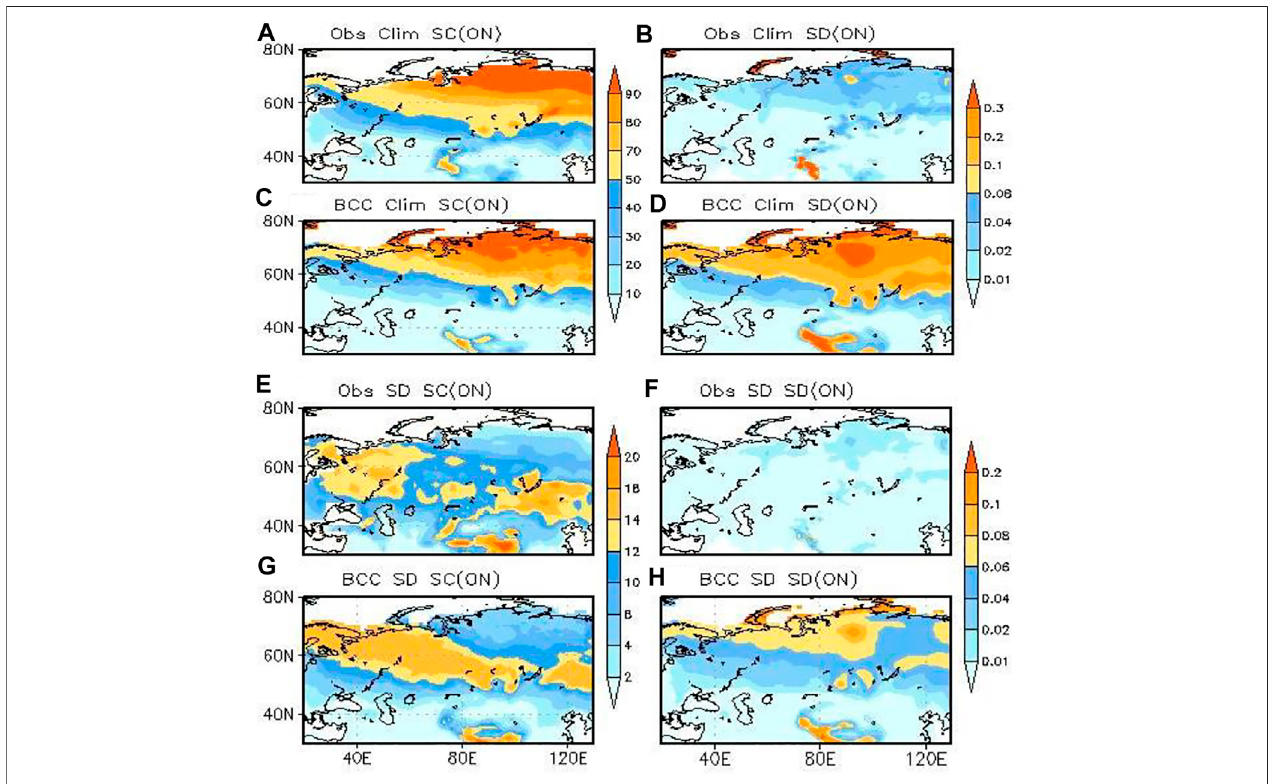
FIGURE 16 | The climatological ON mean (A) fractional snow cover (units: %), (B) snow depth (units: m) of observation, the simulated (C) fractional snow cover (units: %), and (D) snow depth (units: m) from BCC-CSM2-MR simulations. The standard deviation of ON mean (E) fractional snow cover (units: %), (F) snow depth (units: m) of observation, the simulated standard deviation of (G) fractional snow cover (units: %), and (H) snow depth (units: m) from BCC-CSM2-MR simulations.